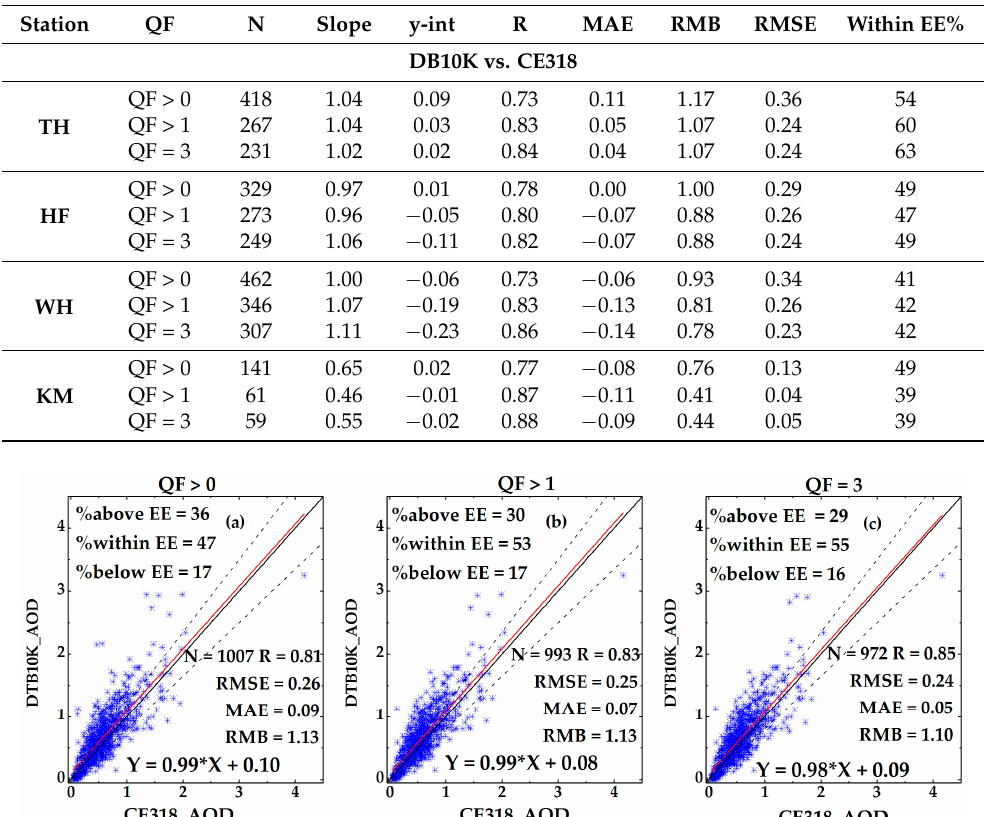
Table 5. As in Table 3, but comparison of the DB10K AOD products.